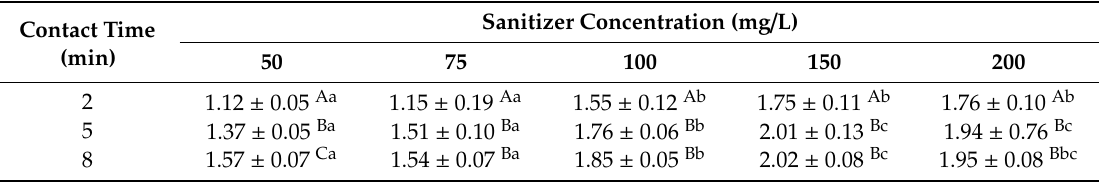
Table 3. Microbial count reduction (log CFU / g) of Listeria monocytogenes after washing with di ff erent concentrations of